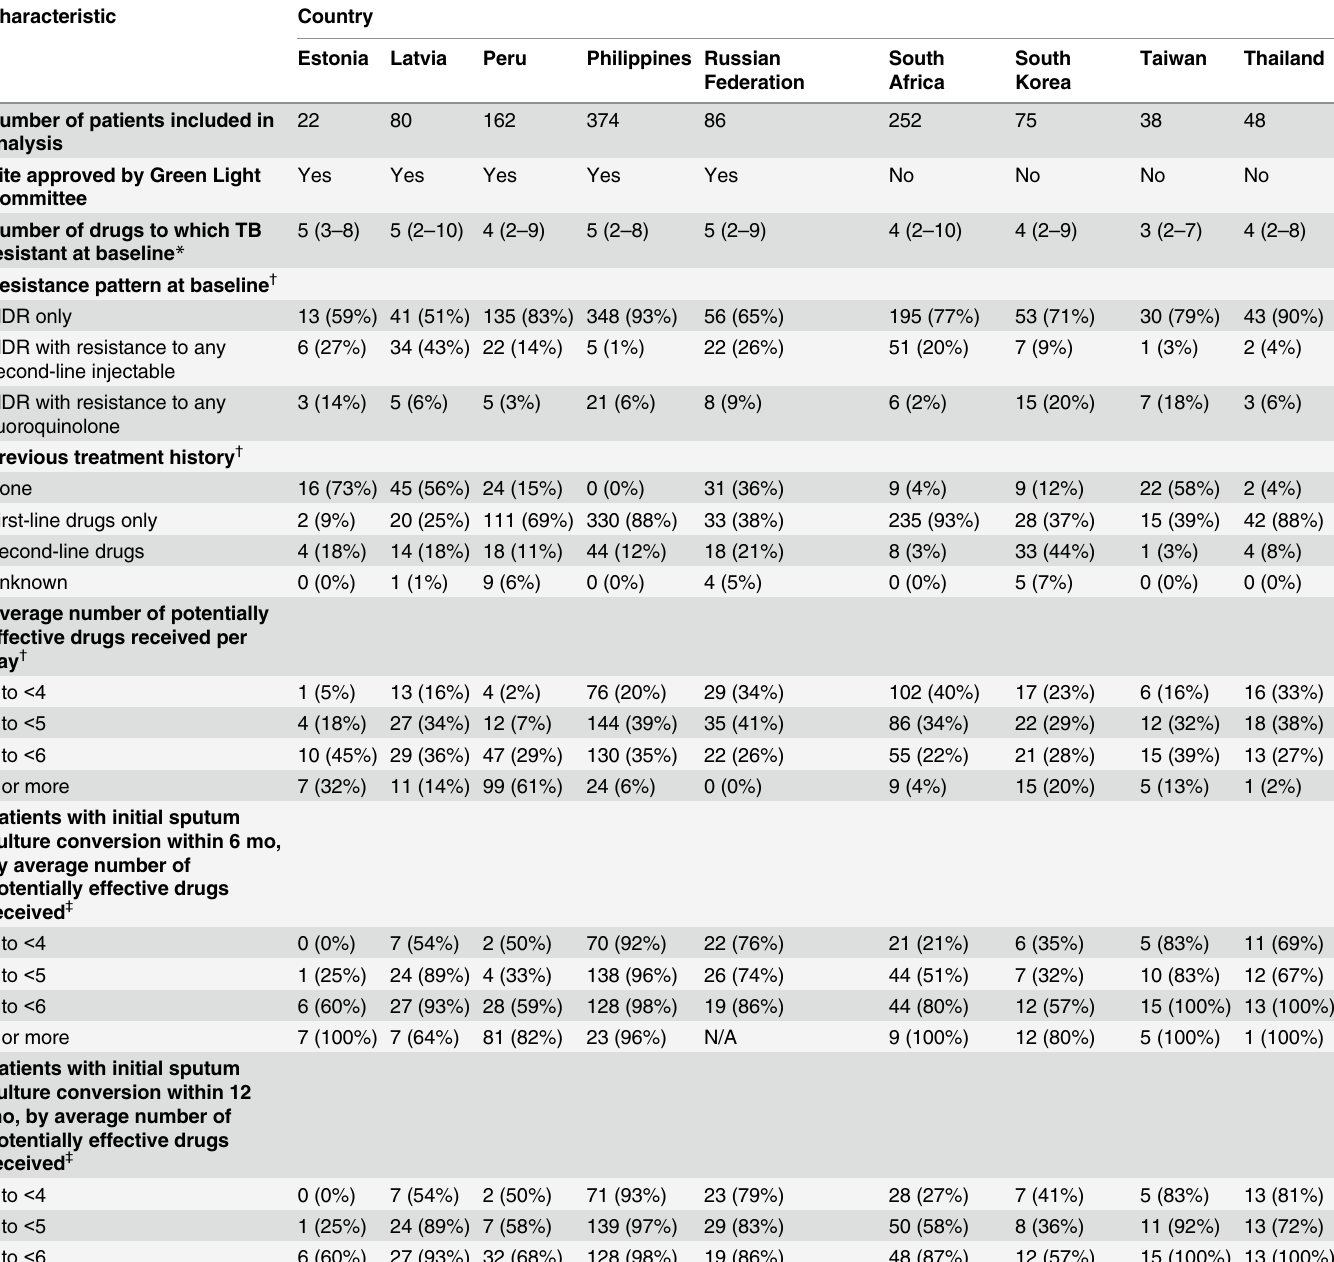
Table 1. Baseline drug resistance and treatment characteristics of patients, by country ( n = 1,137).